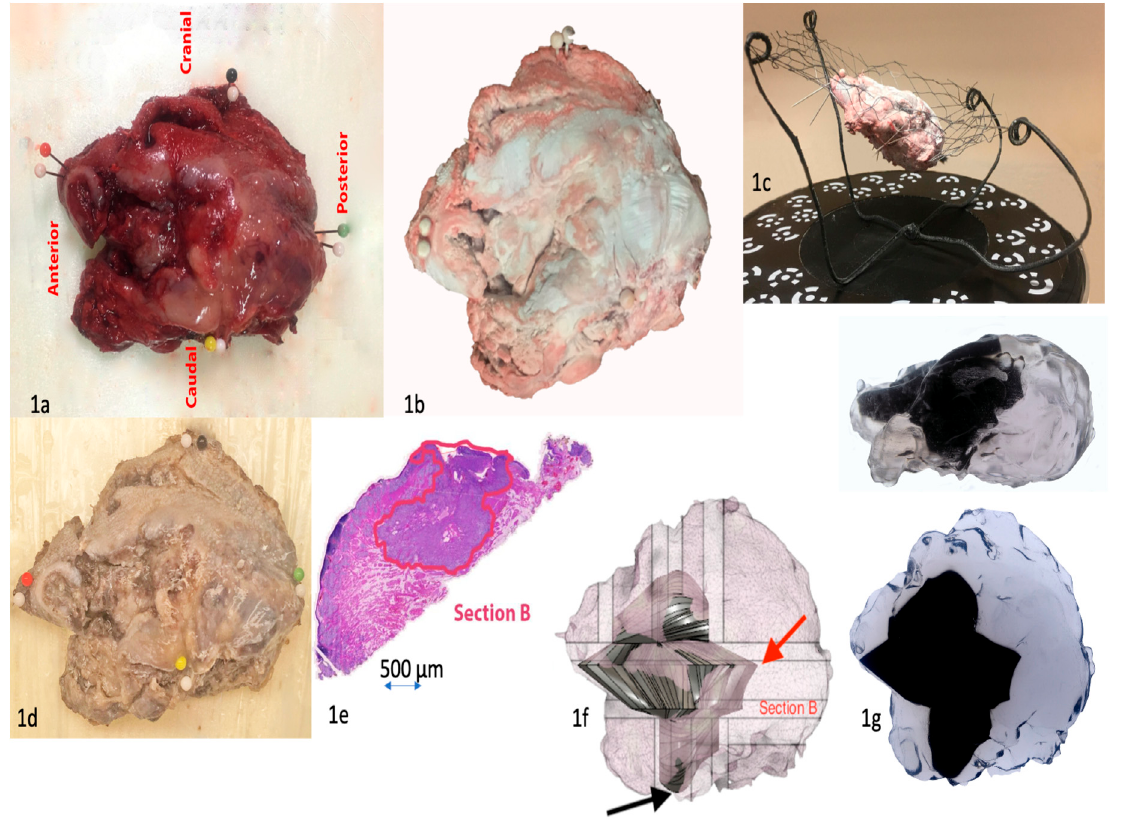
Figure 1. ( 1a ) Resection specimen of the tongue with orientation. Needle colors indicate respective orientations, white needles are markers for scanning. ( 1b ) Resection specimen in the scanning rack, top view. The specimen has been treated with white optic spray. ( 1c ) Resection specimen in the scanning rack, side view. ( 1d ) Resection specimen after formalin fixation and tissue coloring. ( 1e ) Digitalized tumor outline (red) drawn by the pathologist. ( 1f ) Digitalized resection specimen and modeled tumor. The closest margin in the resection specimen was 0.1 mm towards the bottom of the specimen (black arrow). This site was towards the neck, which was removed separately for technical reasons. The 3D model better demonstrates this site to the clinician. The largest margin was posteriorly 20 mm (red arrow). ( 1g ) 3D printed object of the resection specimen and modeled tumor. The tumor has an angular appearance because its surface has been approximated as a plane between adjacent and perpendicular tumor outlines. If the number of histological slices is increased, hence increasing also the number of tumor outlines, the tumor surface will be